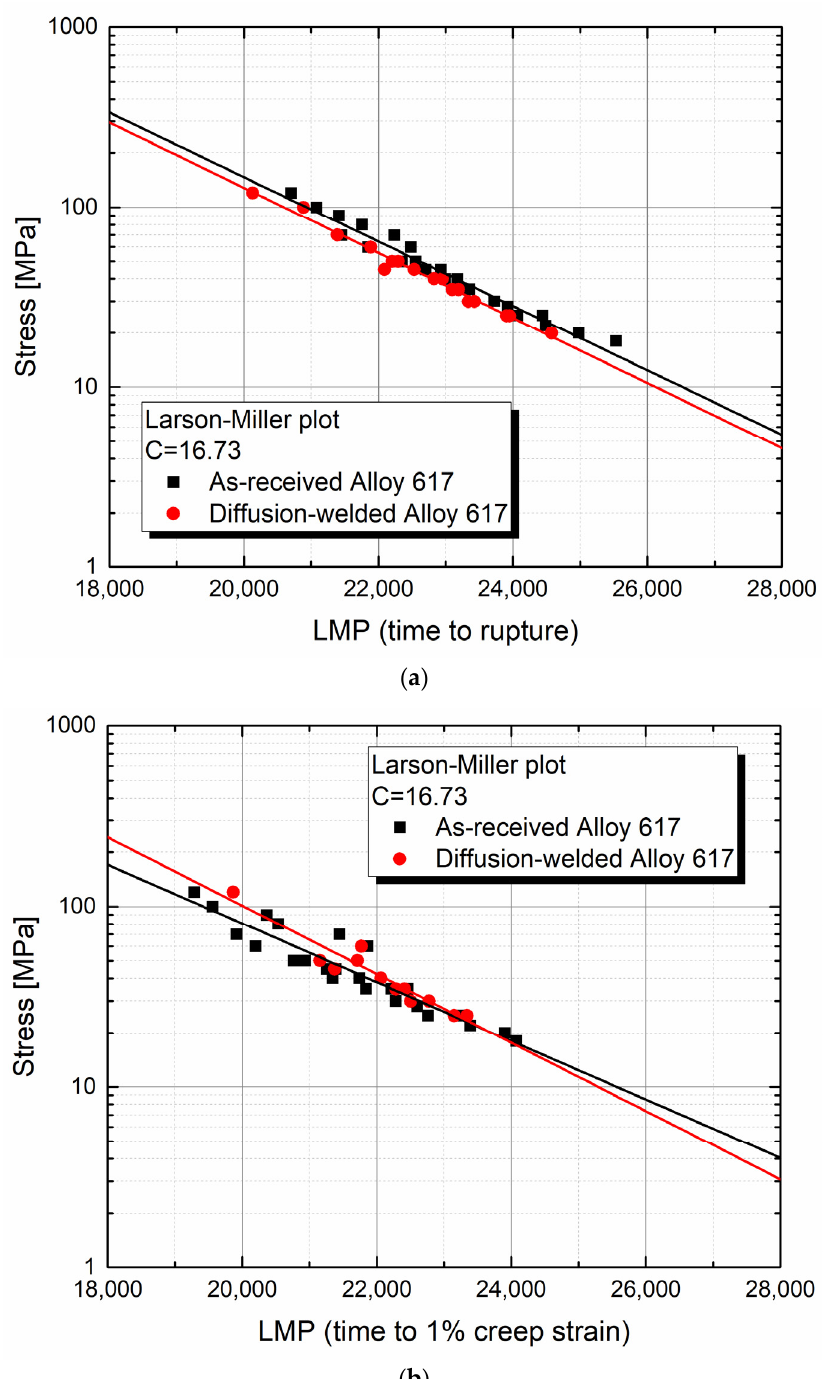
Figure 7. The plot of log stress versus LMP of the diffusion-welded Alloy 617. LMP is drawn for ( a ) the time to rupture and ( b ) the time to 1% creep strain. LMP of the as-received Alloy 617 (black square and black line) is drawn for comparison. Data of the as-received Alloy 617 were collected from Refs. [61–63].